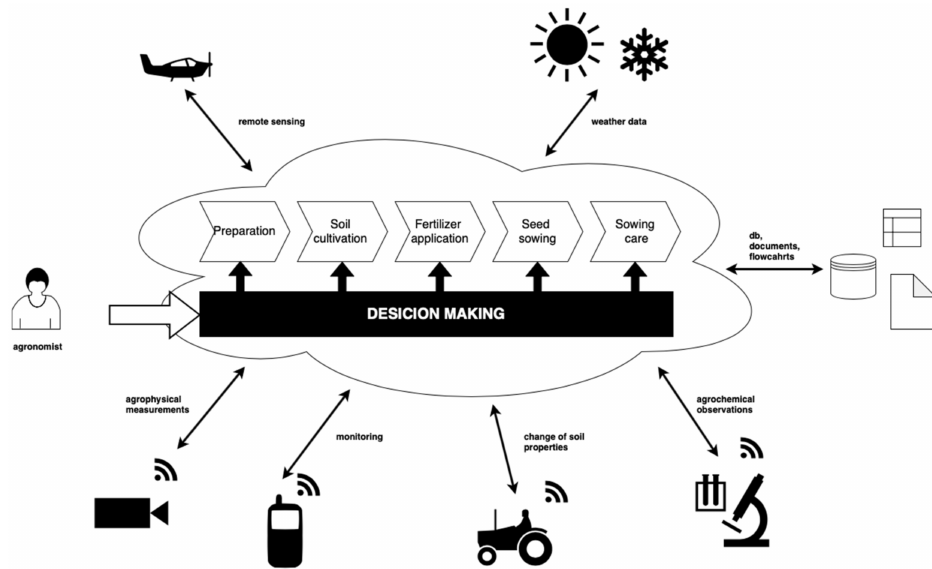
Figure 1. Simplified diagram of precise agriculture